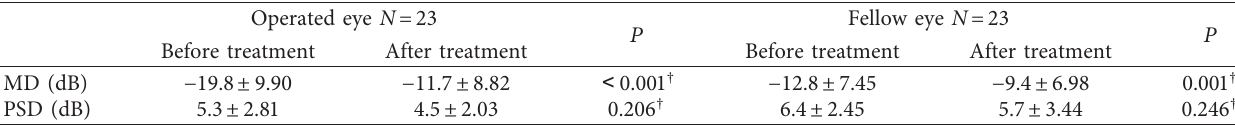
Table 4: Visual field parameters of the operated eyes and fellow eyes in patients with bilateral DON before and after